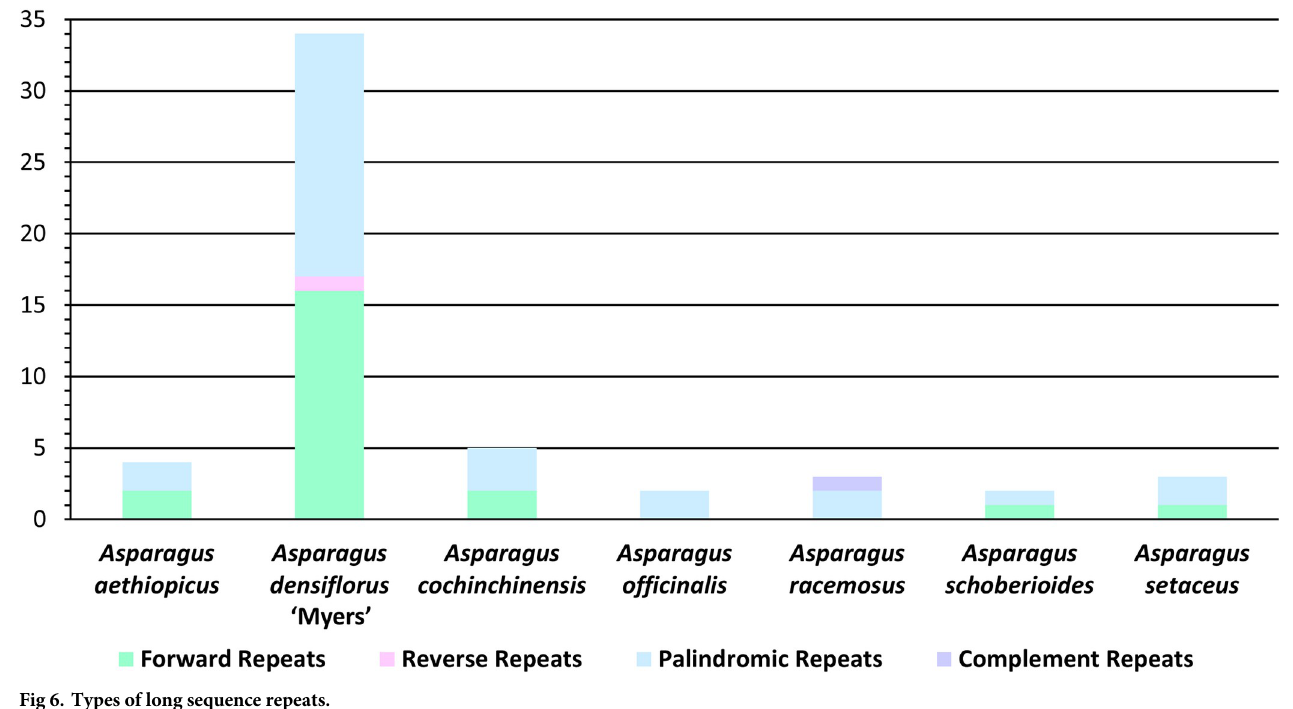
PLOS ONE | https://doi.org/10.1371/journal.pone.0266376 April 25,